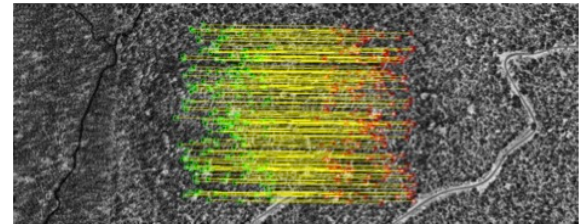
Figure 10: Matches for descriptor based only on elevation data